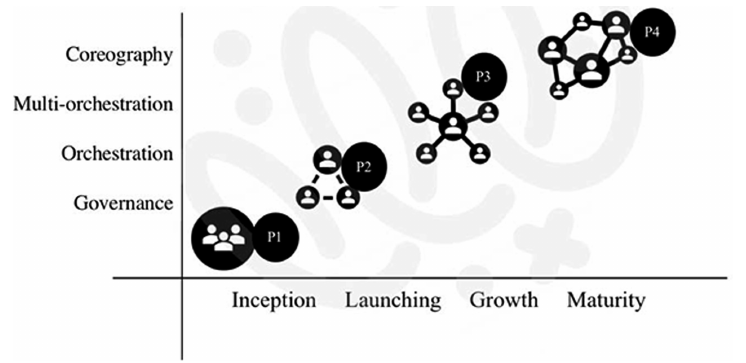
Figure 1. Framework of Actors ’ CoordinationintheLife Cycle of Innovation